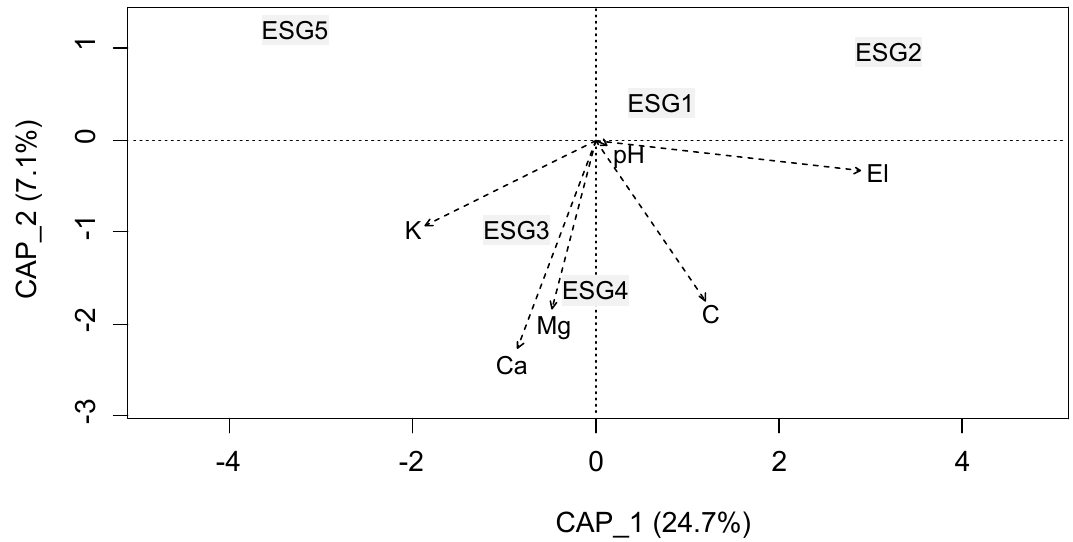
Figure 2. Results of a Constrained Analysis of Principal Coordinates showing the position of ecological species groups at the first two restricted ordination axes. The gradients of the ordination axes were modelled by significant environmental parameters selected in a stepwise procedure with backward elimination. Table 2. Standard deviation of the most important environmental variables between species groups in the study area.